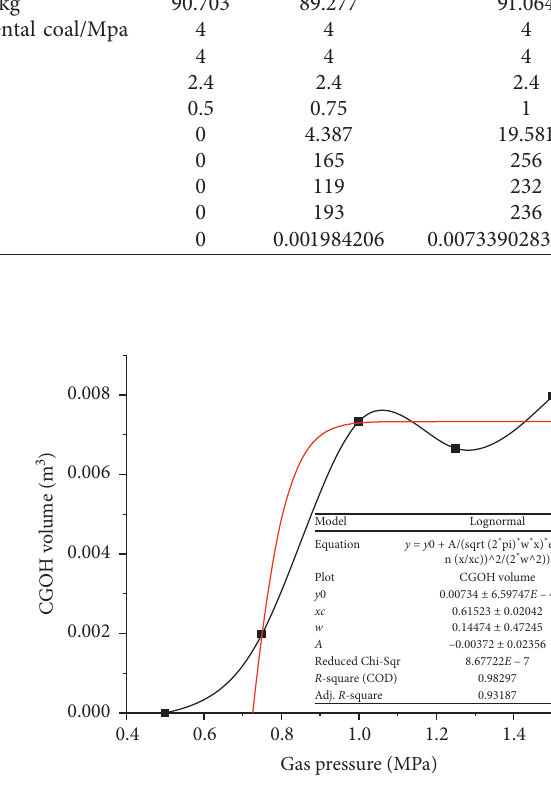
Figure 25: Fitting gas pressure and volume with the lognormal function.